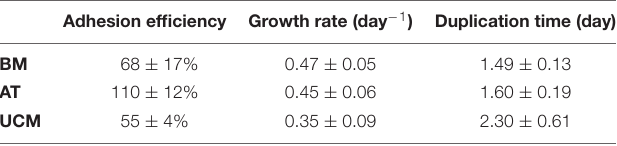
TABLE 1 | Parameters from cultures of MSC from three different human sources (BM, AT, and UCM) in